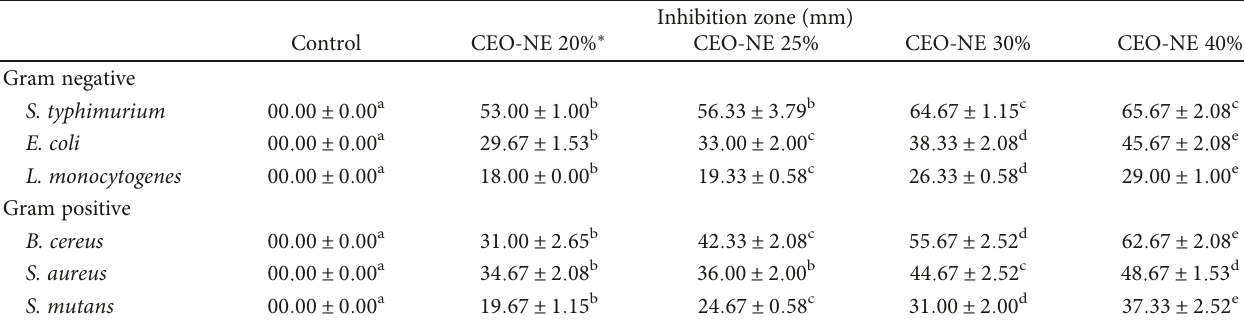
Table 3: Antibacterial activities of the control and CEO-NE-alginate fi lms. Di ff erent letters in the same row indicate signi fi cant di ff erences at p < 0 05 by the ANOVA test. ∗ The percentages indicate the amount of nanoemulsion incorporated into the fi lms (%, v / w ), based on total fi lm- forming solution. Control =pure alginate fi